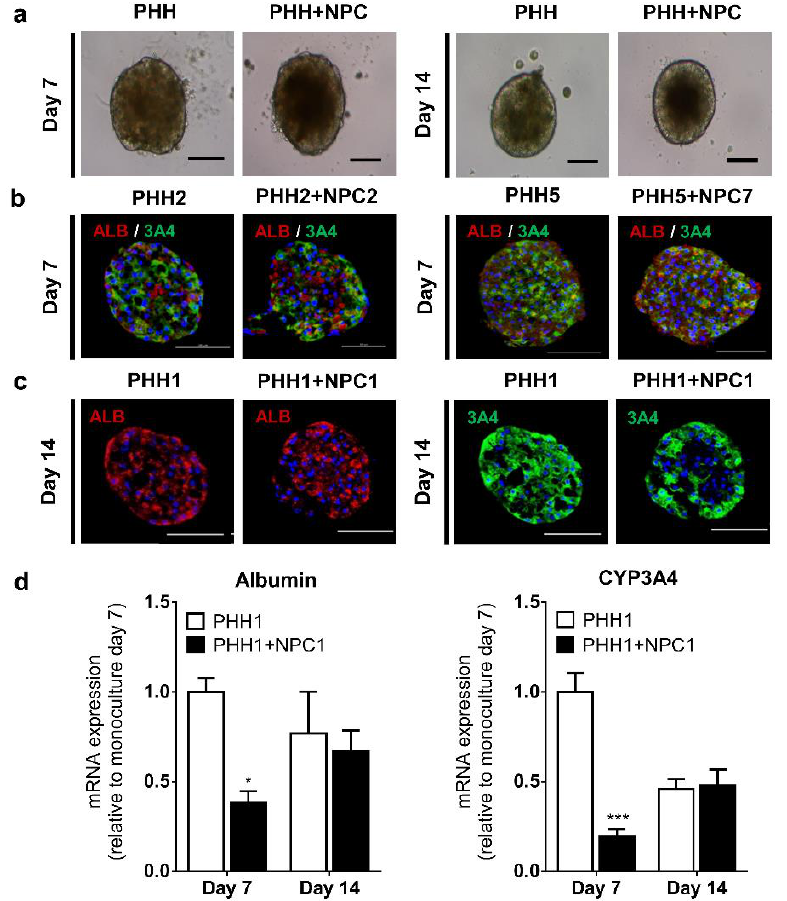
Figure 1. Hepatocyte markers in monoculture and co-culture spheroids. Typical spheroid morphology was maintained across monoculture and co-culture spheroids ( a ) over 14 days. Protein expression of albumin and CYP3A4 in monoculture and co-culture spheroids from di ff erent donors was evident at day 7 ( b ). Monoculture and co-culture spheroids expressed comparable albumin and CYP3A4 protein at day 14 ( c ). mRNA expression of albumin and CYP3A4, using the same donor (n = 3), at day 7 and 14 ( d ). ALB: albumin, 3A4: CYP3A4. * p < 0.05, *** p <